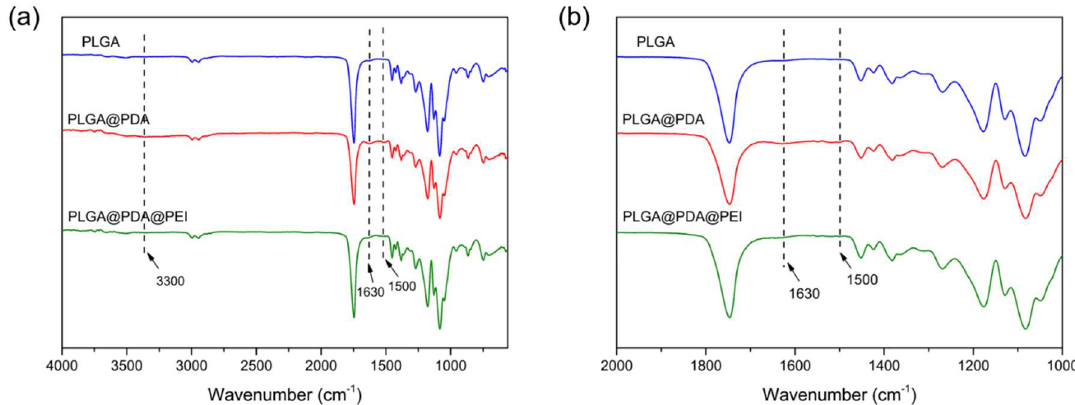
Figure 6. FTIR spectra with a scale of 4000~500 cm −1 ( a ) and 2000~1000 cm −1 ( b ) of the PLGA